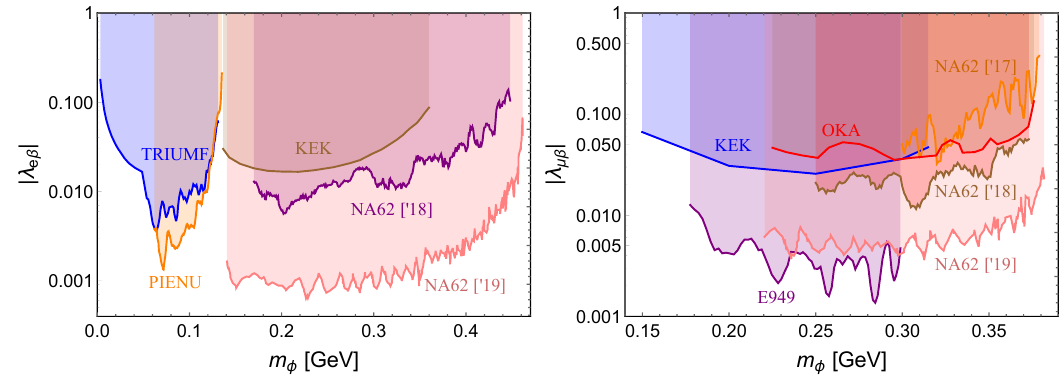
Figure 3 . Limits on j (cid:21) e(cid:12) j (left panel) and j (cid:21) (cid:22)(cid:12) j (right panel) with (cid:12) = e; (cid:22); (cid:28) from heavy